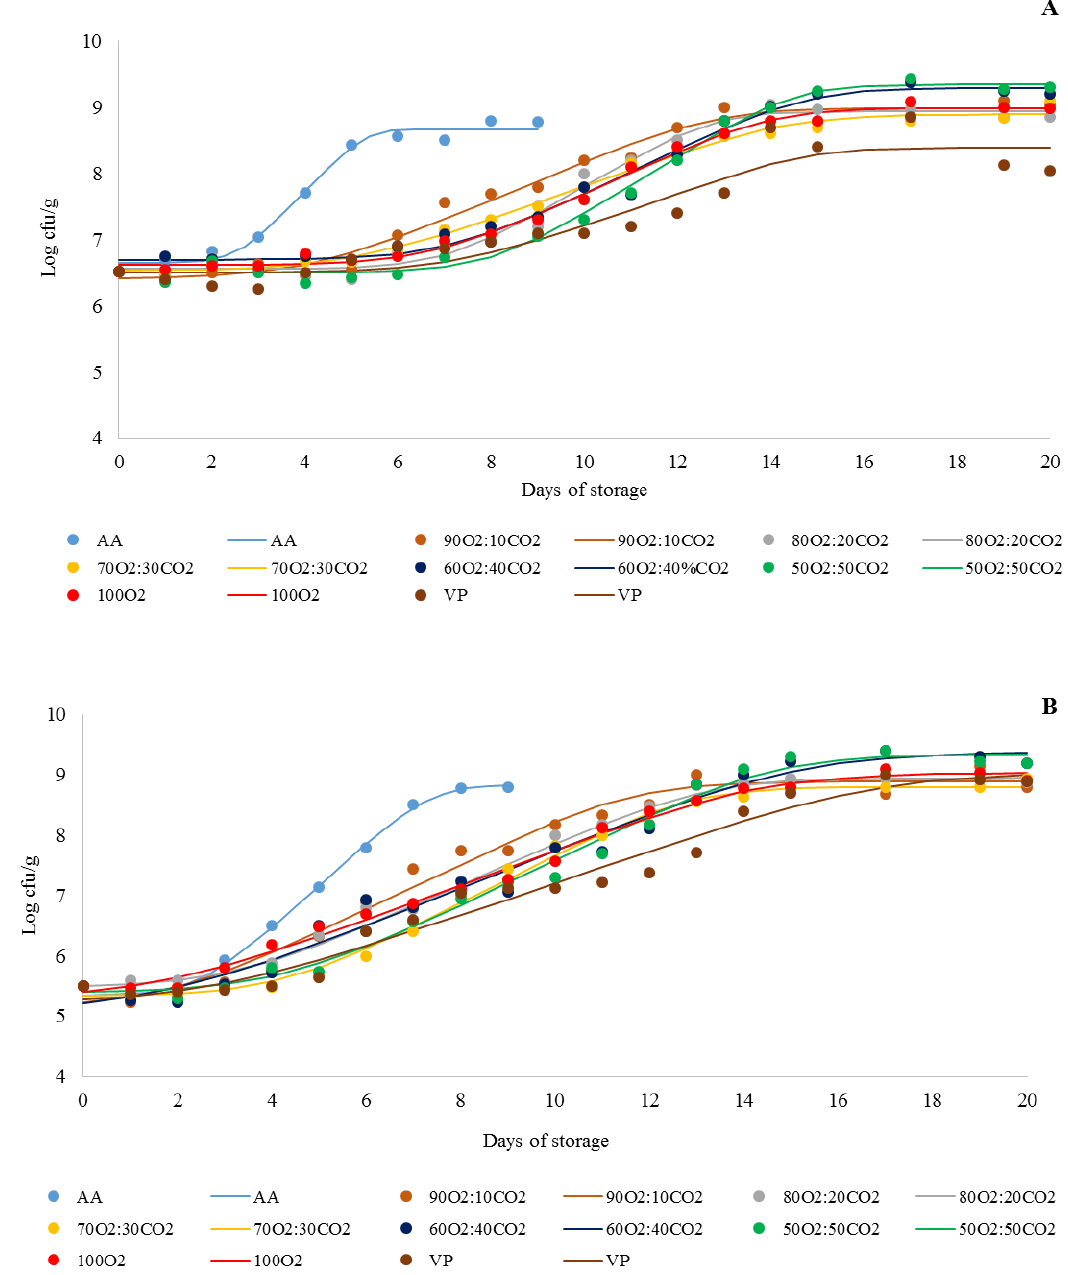
Figure 3. Growth curve of aerobic mesophilic heterotrophic bacteria ( A ) and aerobic psychrotrophic heterotrophic bacteria ( B ) of ground beef treated with different packaging systems stored at 2 °C for 20 days. AA (ambient air); 90O 2 :10CO 2 , 80O 2 :20CO 2 , 70O 2 :30CO 2 , 60O 2 :40CO 2 , 50O 2 :50CO 2 , and 100O 2 (modified atmosphere packaging with 90%:10%, 80%:20%, 70%:30%, 60%:40%, 50%:50%, and 100%:0% oxygen and dioxide carbon ratios, respectively); VP (vacuum packaging). Log cfu/g—Log colony forming units per gram. Filled circles indicate the real average values ( n = 2), and lines represent the values fitted by the predictive primary model designed by Baranyi and Roberts [17].